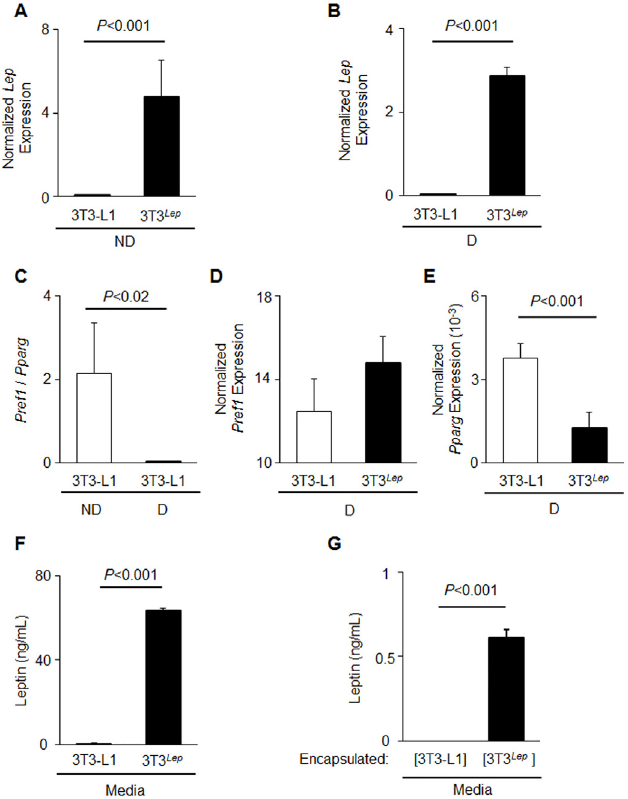
Fig 1. Engineered 3T3-L1 adipocytes express and constitutively secrete leptin. 3T3-L1 cells were stably transduced to overexpress Lep (3T3 Lep ) (A, B) Lep expression in non-differentiated preadipocytes (ND = non-differentiated) (A) and differentiated preadipocytes (D = differentiated) (B) is shown for 3T3-L1 (white bar) and 3T3 Lep (black bar) (both n = 4, P < 0.001). All gene expression was measured by qRT-PCR and normalized to TATA box binding protein (TBP). (C) The ratio of Pref1 to Pparg expression non- differentiated (ND, white bar) and differentiated (D, black bar) and 3T3-L1 (white bar) (n = 3, P < 0.02). (D, E) Pref1 (D) and Pparg (E) expression in differentiated (both n = 4) 3T3-L1 (white bar) and 3T3 Lep (black bar, P < 0.001). (F) A mouse leptin ELISA was performed on media collected from confluent differentiated 3T3-L1 (white bar) and 3T3 Lep (black bar) adipocytes that were incubated in this media for 48 hours (n = 4, P < 0.001). (G) Leptin concentration was measured by ELISA in media collected from a monolayer of encapsulated 3T3-L1 ([3T3-L1], white bar) and 3T3 Lep ([3T3 Lep ], black bar) adipocytes cultured overnight. All data are expressed as means ± SD (n = 4, P < 0.001).